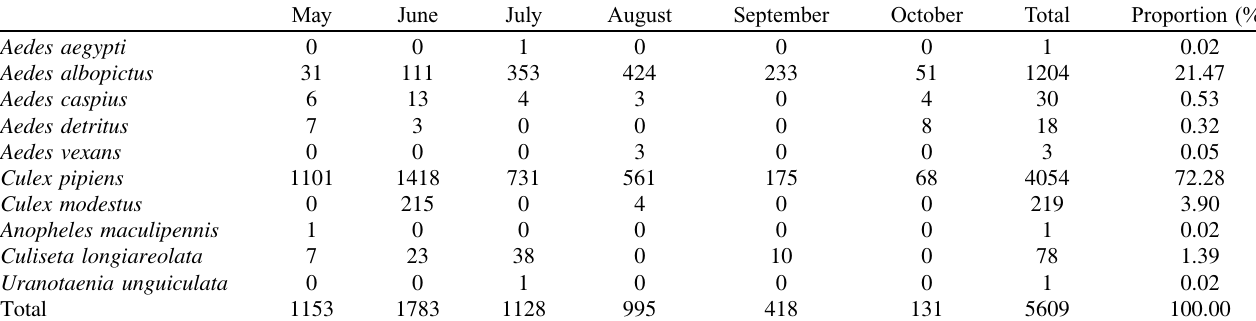
Figure 1. Map of the eastern dock of the “ Grand Port Maritime de Marseille ” (GPMM), France with location of traps, breeding sites and docks. Table 1. Number of mosquitoes caught during the surveillance period by species and